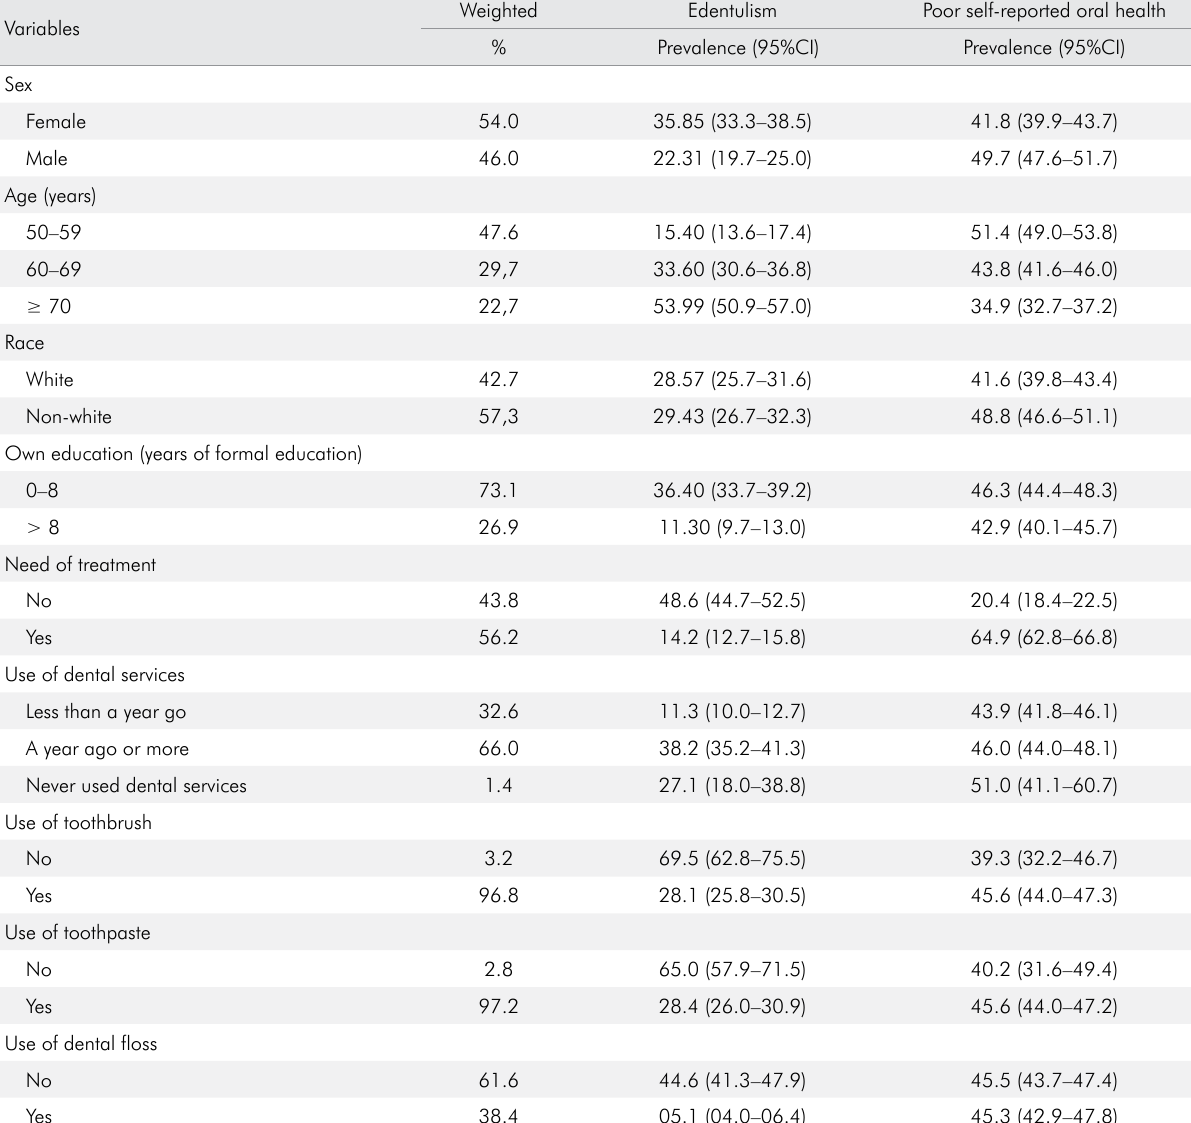
Table 1. Weighted Sample demographic characteristics, socioeconomic adjustment variables, and oral health behavior prevalence and crude prevalence ratios of edentulism and poor self-perception of oral health among older adults at baseline of the Brazilian Longitudinal Study of